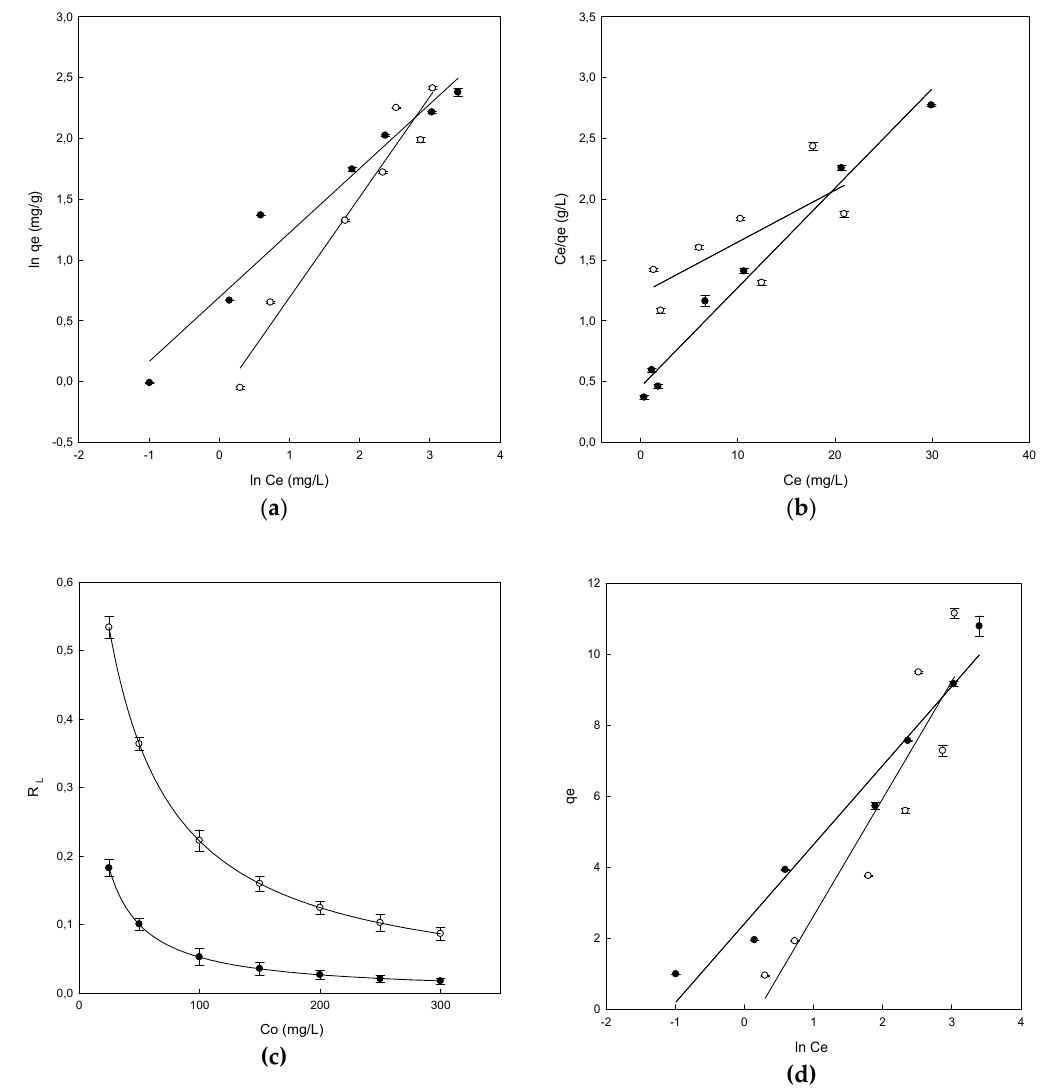
Figure 6. The adsorption isotherms for Direct Blue 78 by chitosan-NaOH ( ● ) and β -CDs-EPI ( ○ ). ( a ) Freundlich isotherm, ( b ) Langmuir isotherm, ( c ) Separation factor, ( d ) Temkin isotherm.